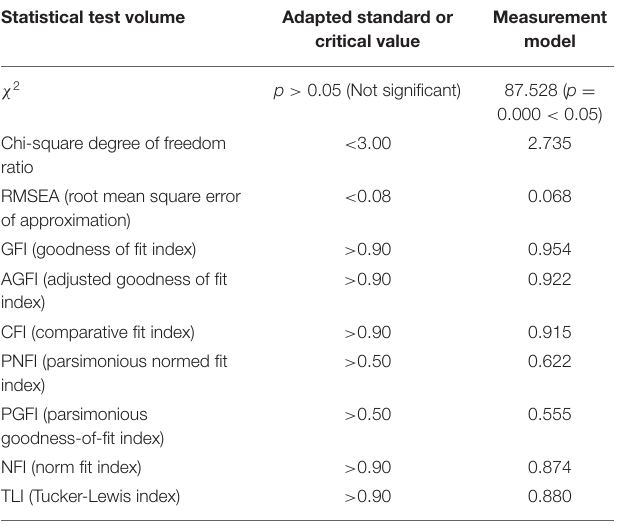
TABLE 8 | Results of the measurement model fitness